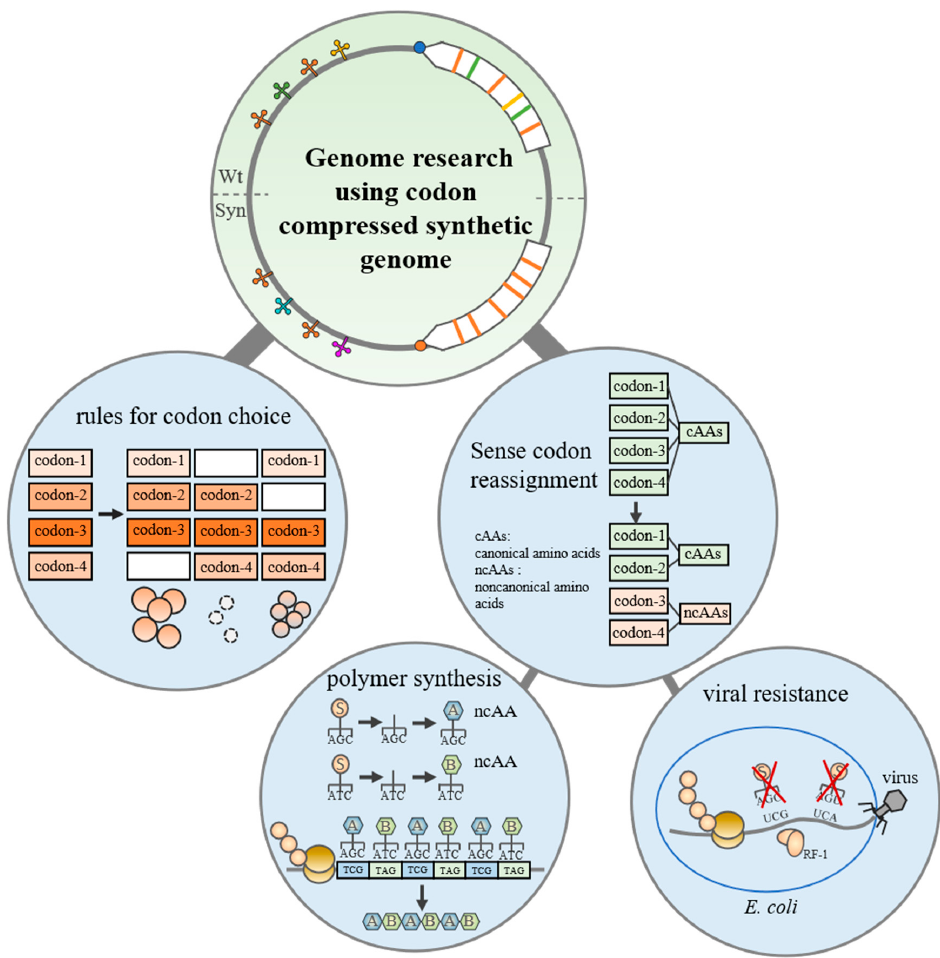
Figure 3. Genome research using a codon-compressed synthetic genome. Allowed and disallowed synonymous recoding schemes were tested and defined. The codon-compressed synthetic genome enables viral resistance and encoded polymer synthesis.